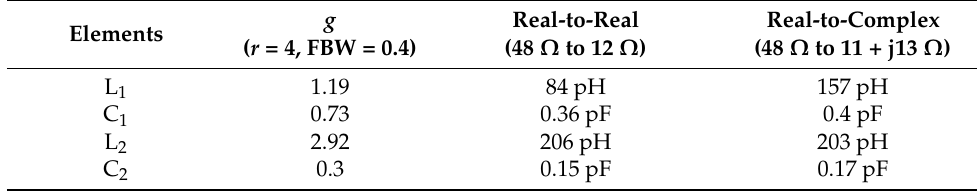
Figure 6. Two-section low-pass MN: ( a ) normalized prototype; ( b ) real-to-complex impedance transformer. Table 3. Design parameters for the low-pass OMN.